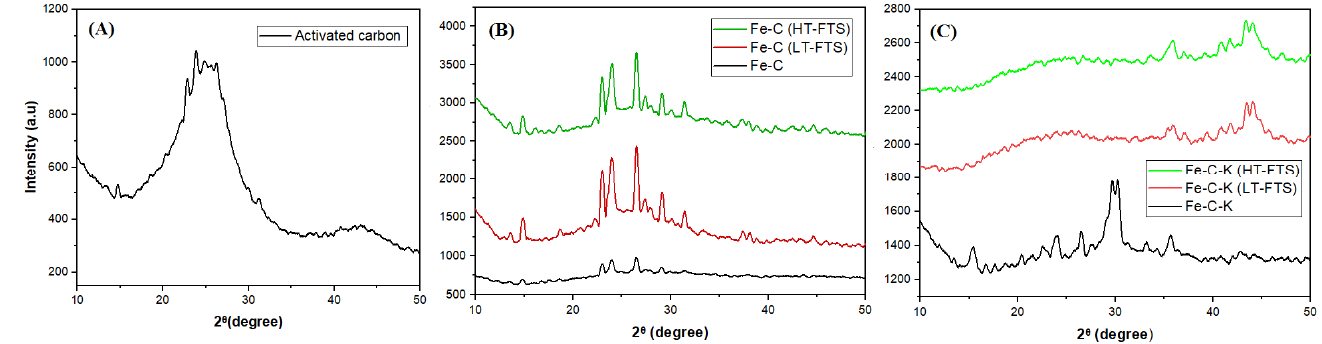
Figure 1. XRD pattern: ( A ) activated carbon; ( B ) Fe-C catalyst, Fe-C LT-FTS, and Fe-C HT-FTS; ( C ) Fe-C-K catalyst, Fe-C-K LT-FTS, and Fe-C-K HT-FTS.